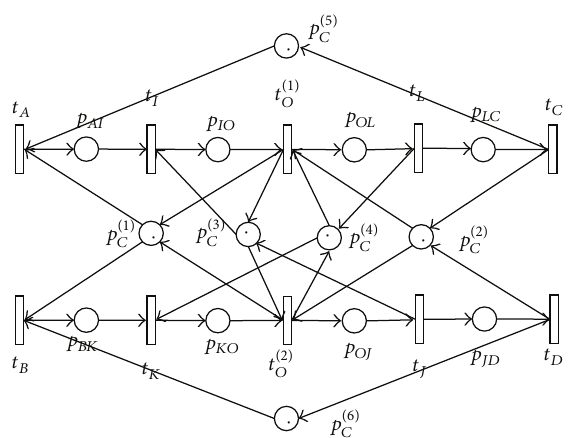
Figure 8: Type I protection-zone conflict-control